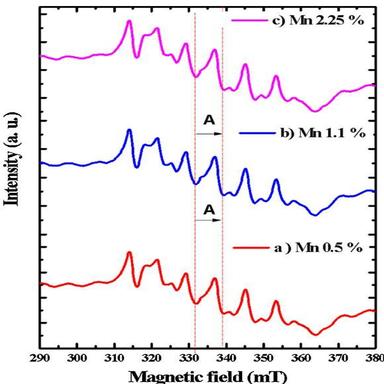
EPR spectra of ZnO/MnO nanocomposite with different Mn contents: a) 0.5%, b) 1.1% and c) 2.25%.